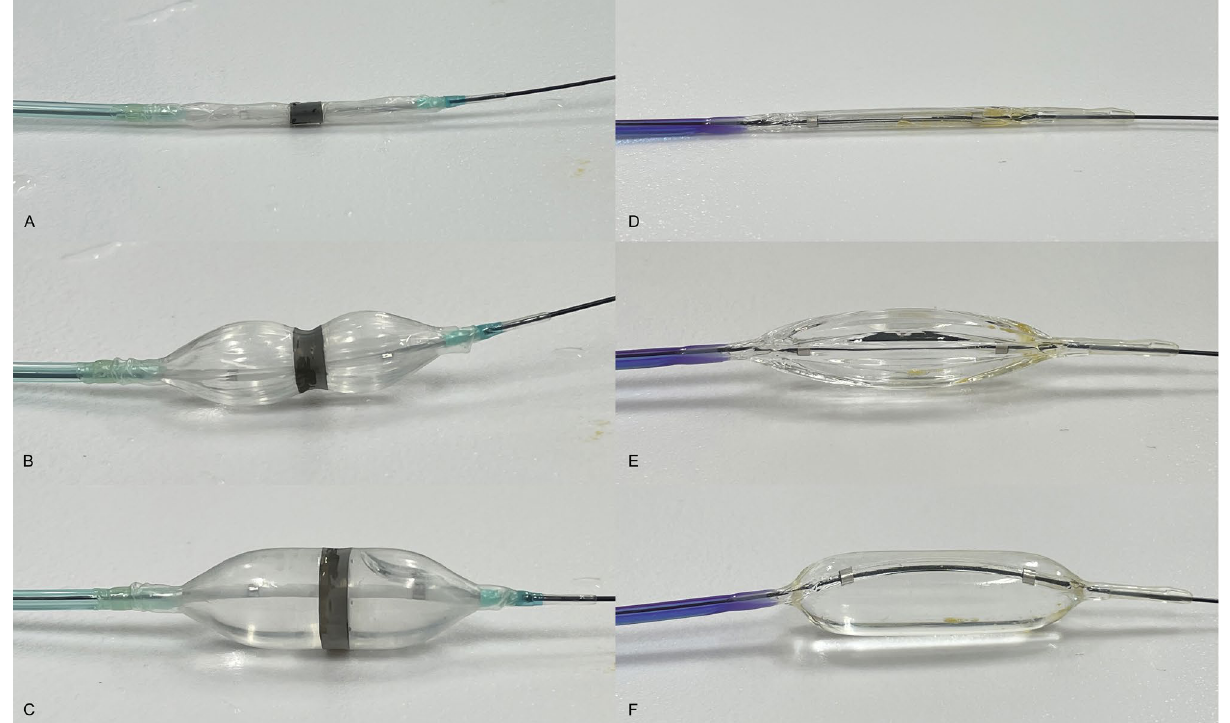
Figure 1. Novel non-slip balloon: before ( A ), during ( B ), and after ( C ) inflation. Conventional balloon: before ( D ), during ( E ), and after ( F ) inflation. A ductile ring-band attached over the non-slip balloon causes the central part of the balloon to expand with delay during balloon inflation, thus preventing balloon slippage.